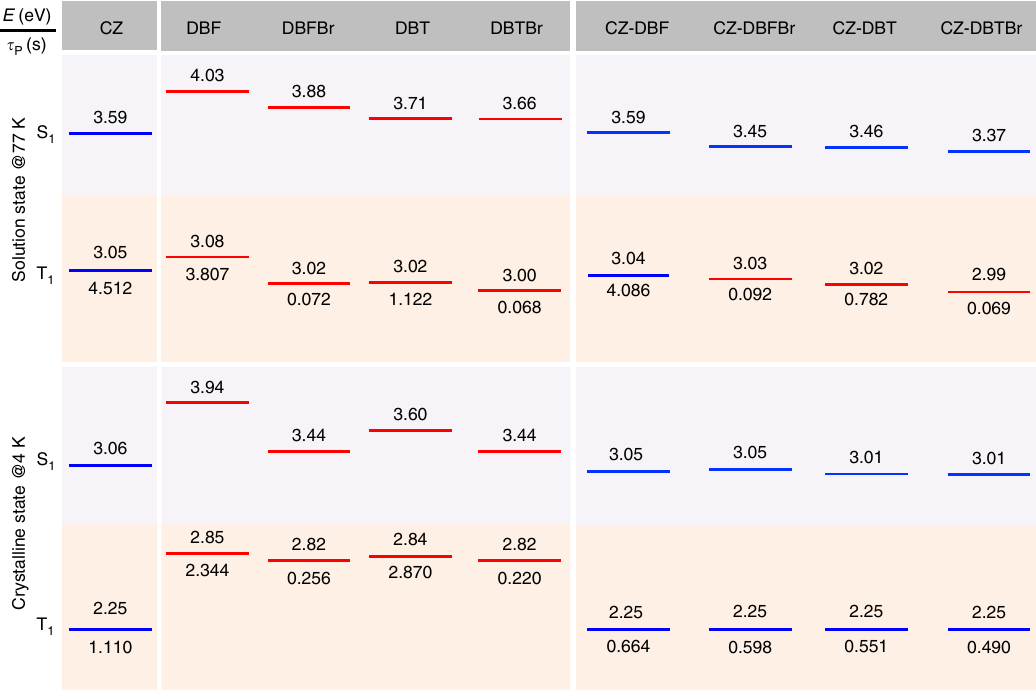
Fig. 4 Energy levels and lifetimes of the model fragments and integrated molecules. The energy levels were calculated from the 0 – 0 peaks or the onsets of the emission